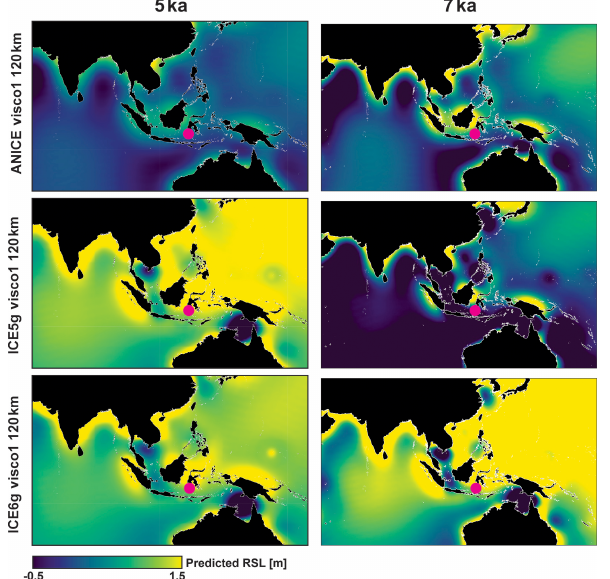
Figure 6. Relative sea level at 5ka (left) and 7ka (right) as pre- dicted by three of the GIA models used in this study. See Table 1 for the definition of the mantle viscosity here labeled “Visco1”. The purple dot indicates the approximate position of the Spermonde Archipelago.